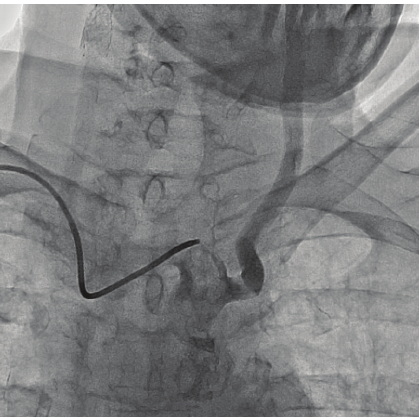
Figure 3: A 5Fr hydrophilic coated vertebral catheter was advanced into the brachiocephalic trunk to engage selectively the left common carotid artery.